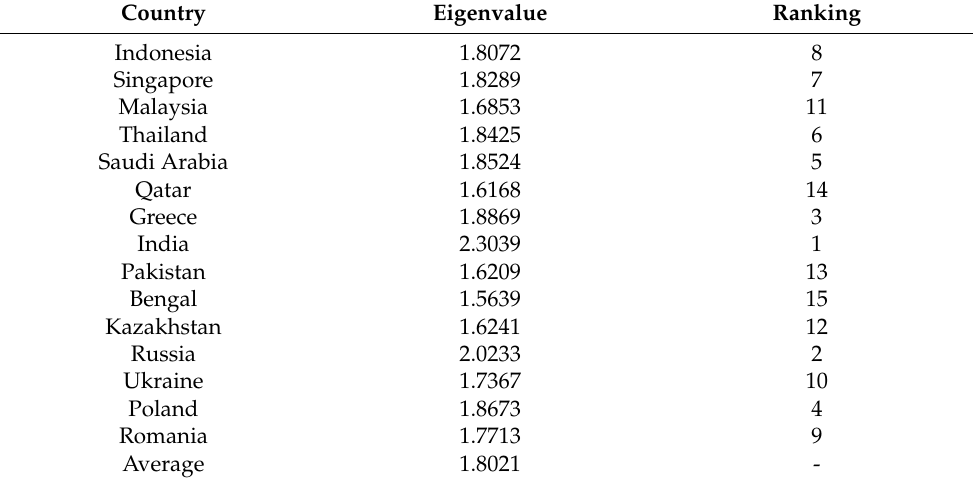
Table 8. Eigenvalue and